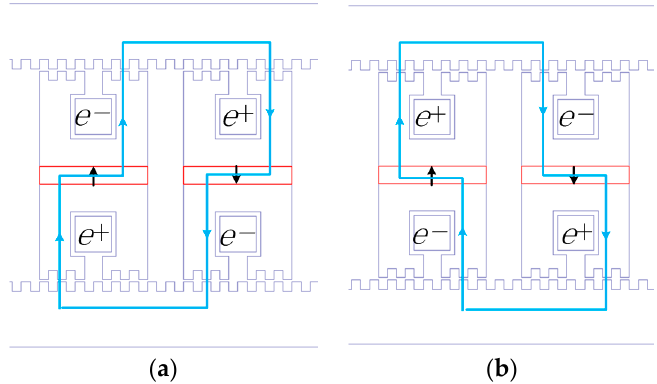
Figure 5. Operation principle of the machine ( a ) the first half period and ( b ) the second half period.